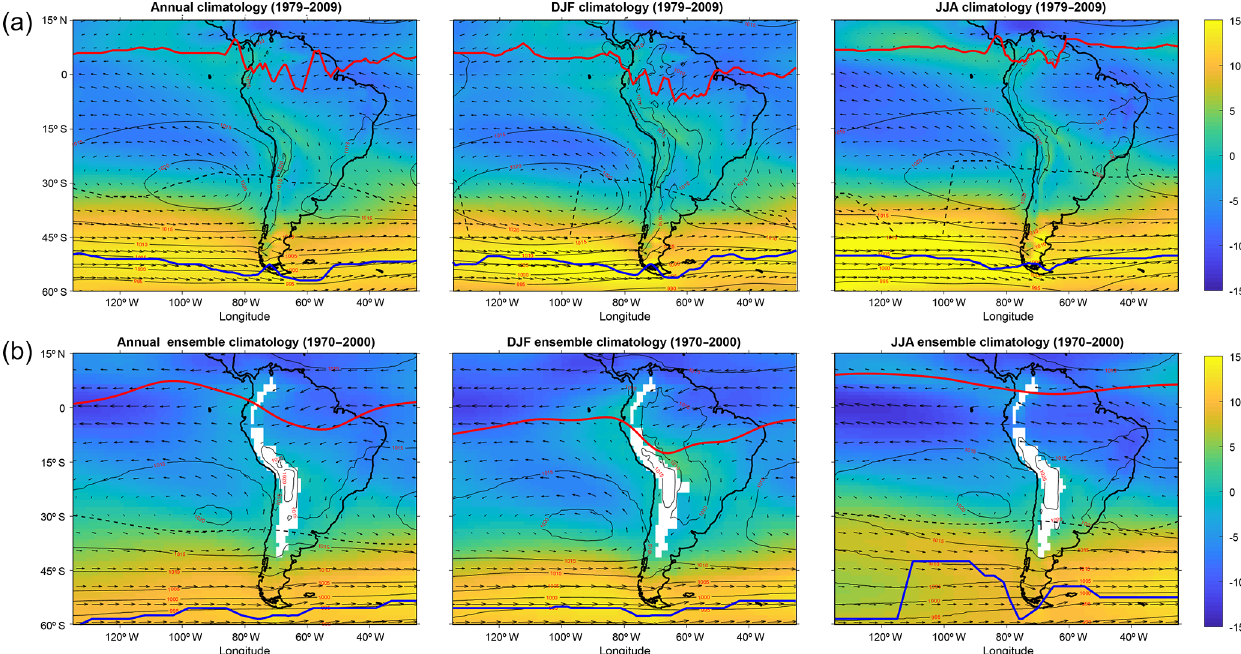
Figure 1. Present-day climate of southwestern South America. (a) ERA-Interim (1970–2009) and (b) ensemble model (1970–2000) clima- tology. Magnitude (color) and direction (vectors) denote the wind stress in the eastern Pacific Ocean for the annual mean, DJF, and JJA. The red line denotes the ITCZ position, the contour line (1020hPa) indicates the SPSH extension, the black dashed line corresponds to the STJ position, and the blue line denotes the position of the